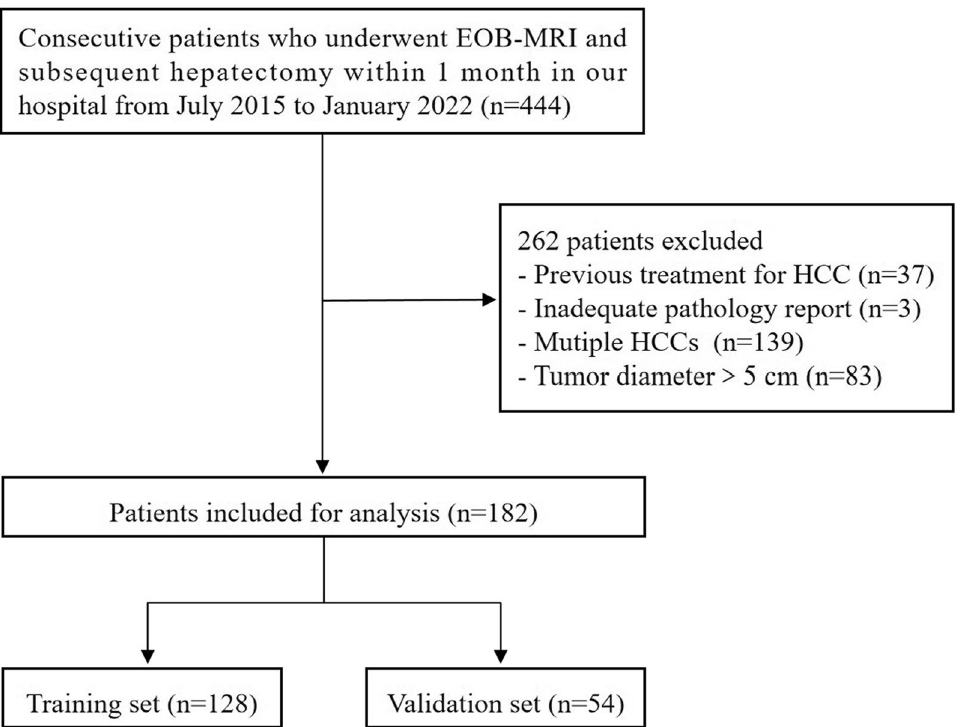
Fig. 1 Flowchart of patient selection. EOB-MRI, gadoxetate disodium-enhanced magnetic resonance imaging; HCC, hepatocellular